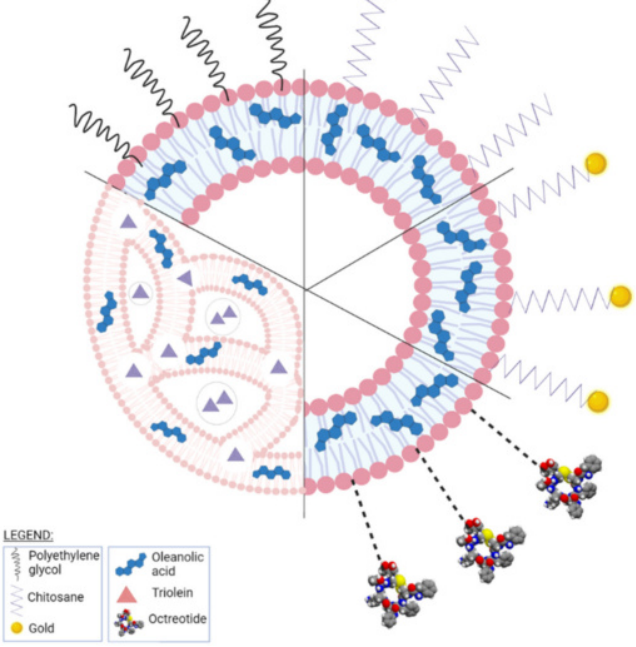
Figure 19. Schematic representation of different reported OA liposomal formulations. Created with BioRender.com (accessed on 10 January